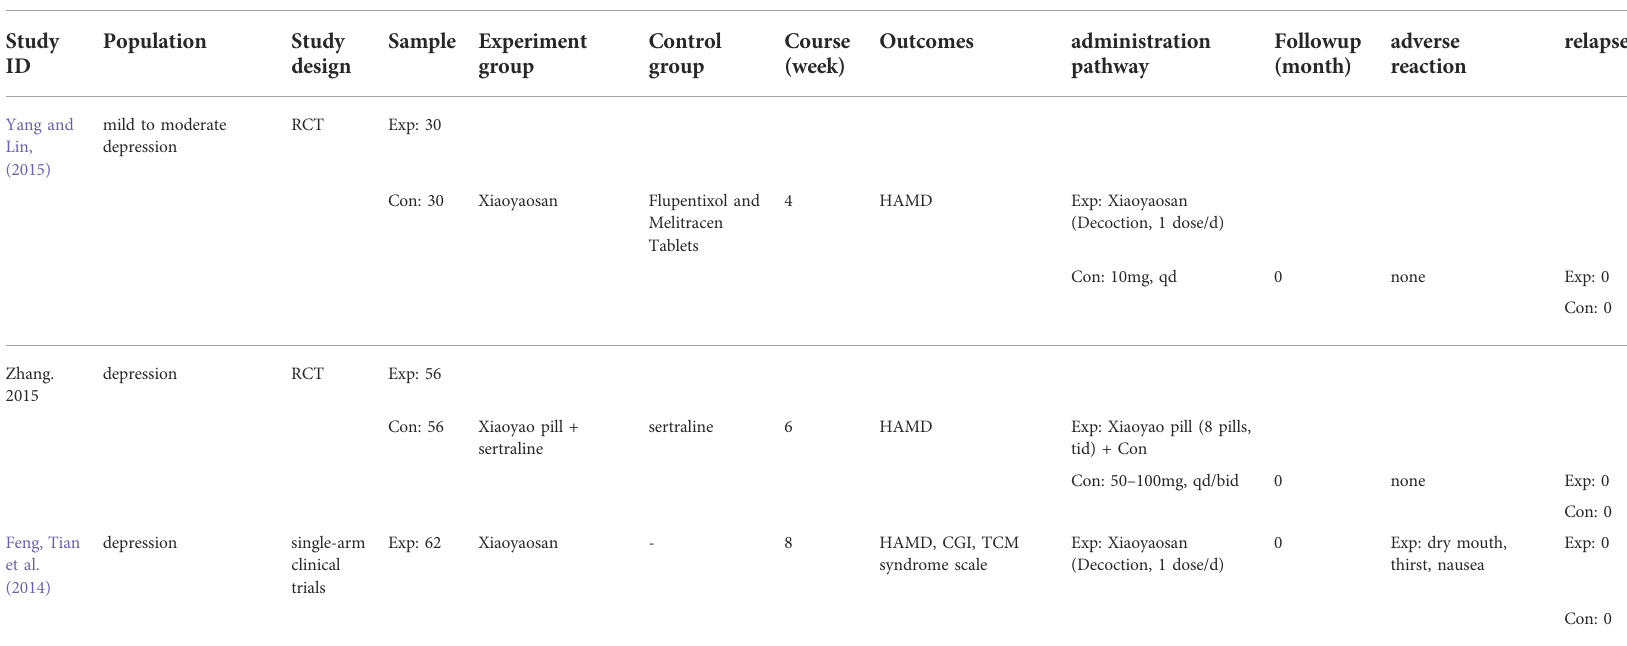
TABLE 2 ( Continued ) The clinical application of XYS in the treatment of